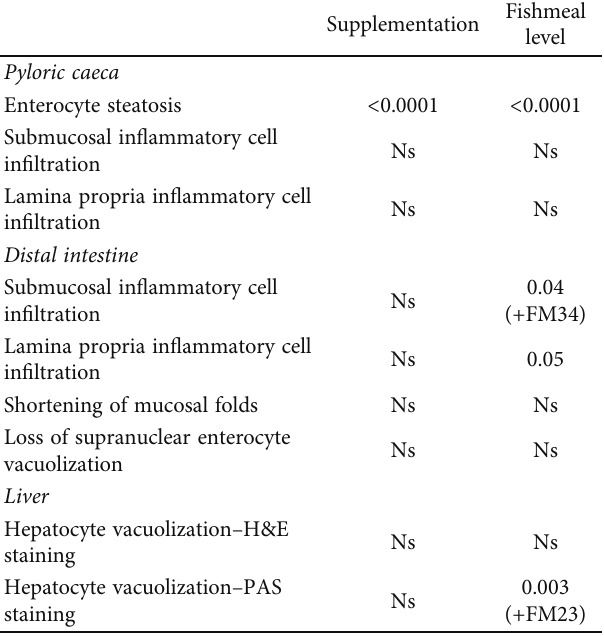
Table 9: Results of an ordinal logistic regression of the impact of supplementation and fi shmeal level on the distribution of the histological scores among the diet groups for a given morphological feature in each of the di ff erent intestinal segments and liver. Numbers of cells are p